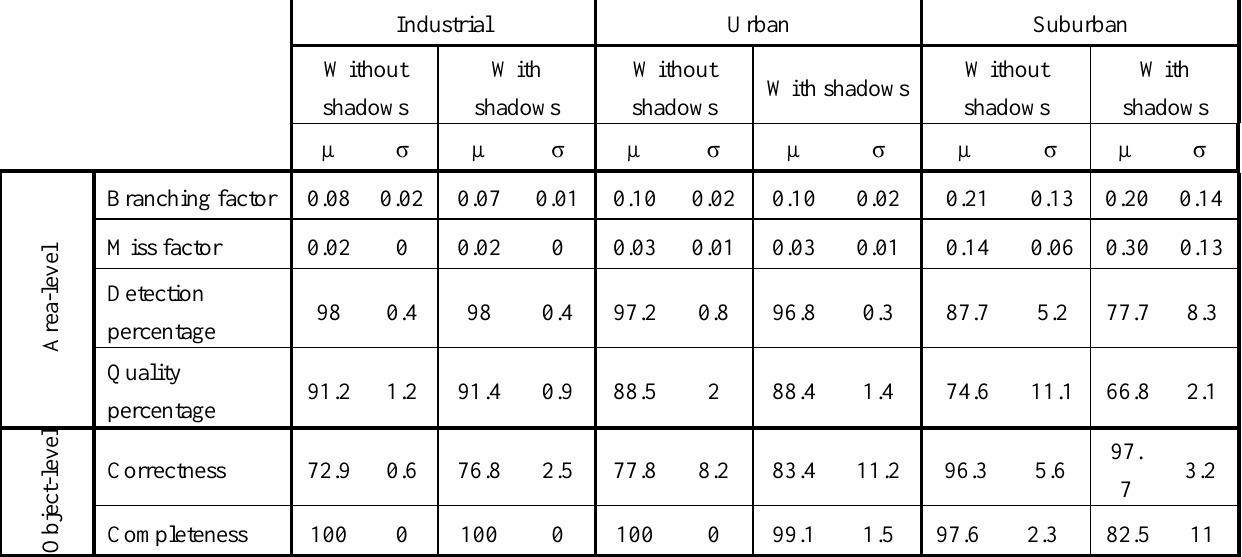
Table 6. Comparison of mean (µ) and standard deviation (σ) of building detection assessment metrics with and without using shadow contextual information for the thresholding-based approach. Industrial Urban Suburban Without With Without Without With With shadows shadows shadows shadows shadows shadows µ σ µ σ